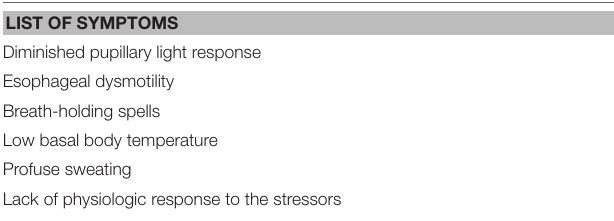
TABLE 1 | Symptoms of the Autonomic Nervous System dysregulation described in CCHS patients. LIST OF